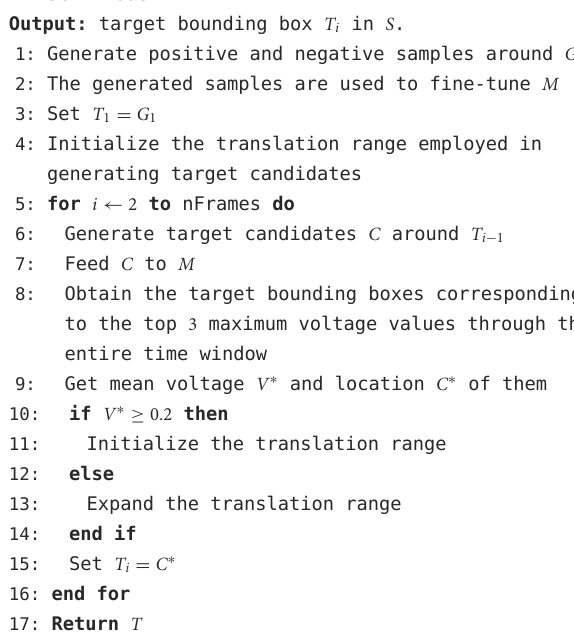
Algorithm 1. The test procedure of tracking with SCTN.